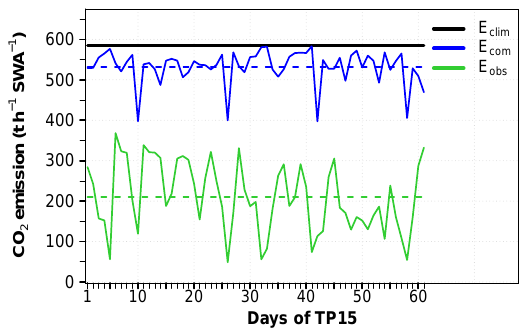
Figure 7. Daily CO 2 emission estimations (th − 1 ) within TP15 from flaring, summed up over the SWA area as denoted in Fig. 1 for the three emission inventories: E clim (climatology, black solid line), E obs (daily VNF flare observations, green solid line and tempo- ral average as green dashed line) and E com (sum of daily VNF flare observations and emissions from cloud-covered flares, blue solid line and temporal average as blue dashed line). The periodical drop of the blue line is linked to reduced data coverage (compare with black bars in Fig.